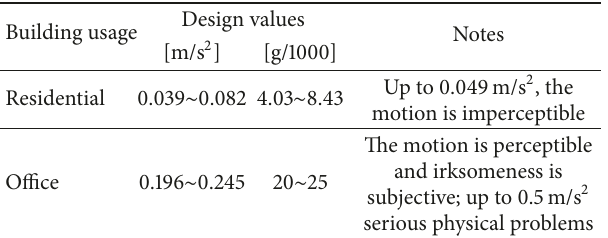
Table 1: Reference values of the acceleration.